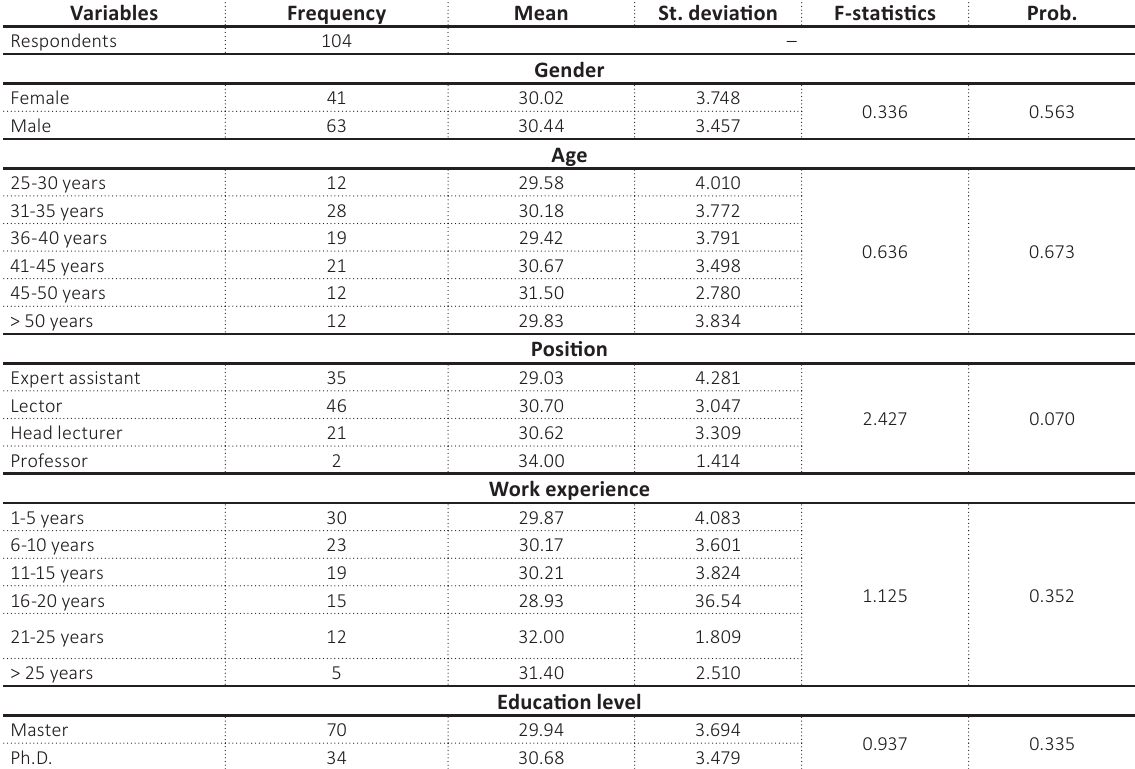
Table 3. One-way ANOVA test on gender, age, position, and education on lecturer performance